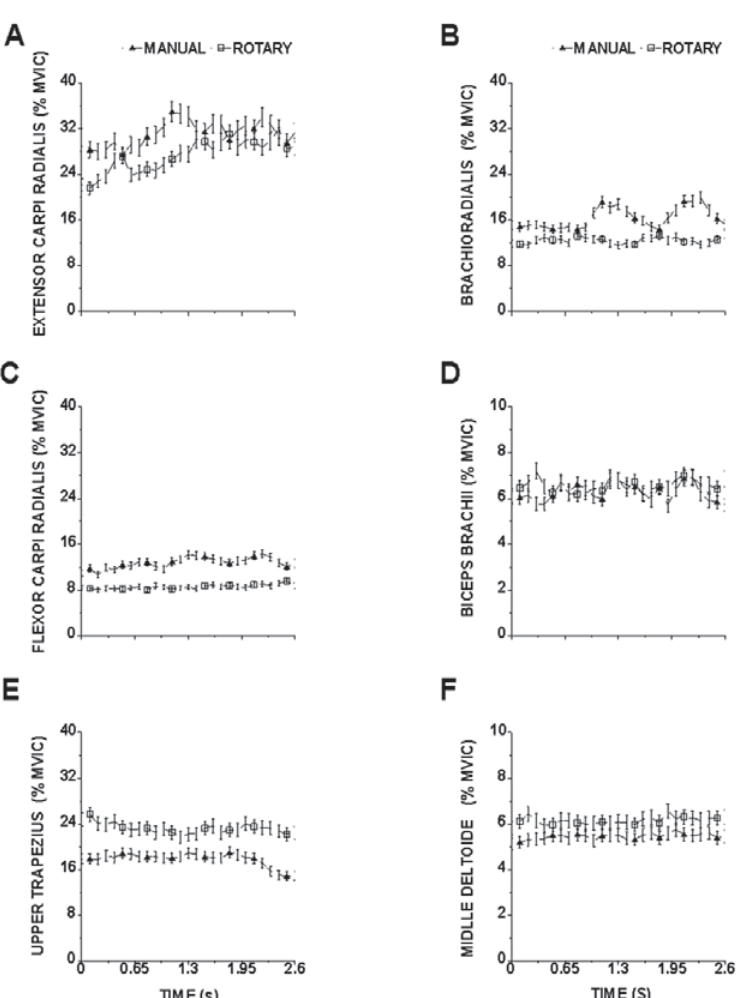
Figure 2- Average and standard error across all subjects of the normalized electromyography (EMG) activity of the extensor (cid:26)(cid:3)(cid:11)(cid:10)(cid:13)(cid:8)(cid:11)(cid:3)(cid:12)(cid:13)(cid:3)(cid:4)(cid:13)(cid:7)(cid:8)(cid:27)(cid:28)(cid:29)(cid:30)(cid:8)(cid:24)(cid:11)(cid:3)(cid:26)(cid:20)(cid:13)(cid:17)(cid:11)(cid:3)(cid:12)(cid:13)(cid:3)(cid:4)(cid:13)(cid:7)(cid:8)(cid:27)(cid:31)(cid:29)(cid:30)(cid:8)(cid:22)(cid:6)(cid:9)(cid:17)(cid:11)(cid:8)(cid:26)(cid:3)(cid:11)(cid:10)(cid:13)(cid:8)(cid:11)(cid:3)(cid:12)(cid:13)(cid:3)(cid:4)(cid:13)(cid:7)(cid:8)(cid:27)!(cid:29)(cid:30)(cid:8)(cid:24)(cid:13)(cid:26)(cid:6)(cid:10)(cid:7)(cid:8)(cid:24)(cid:11)(cid:3)(cid:26)(cid:20)(cid:13)(cid:13)(cid:8)(cid:27)"(cid:29)(cid:30)(cid:8)(cid:5)(cid:10)(cid:10)(cid:6)(cid:11)(cid:8)(cid:16)(cid:11)(cid:3)(cid:10)(cid:6)#(cid:13)(cid:5)(cid:7)(cid:8)(cid:27)$(cid:29)(cid:8)(cid:3)(cid:14)(cid:12)(cid:8)%(cid:13)(cid:12)(cid:12)(cid:4)(cid:6)(cid:8)(cid:12)(cid:6)(cid:4)(cid:16)(cid:17)(cid:13)(cid:12)(cid:8)(cid:27)&(cid:29)(cid:8) during all intervals calculated for each instrumental